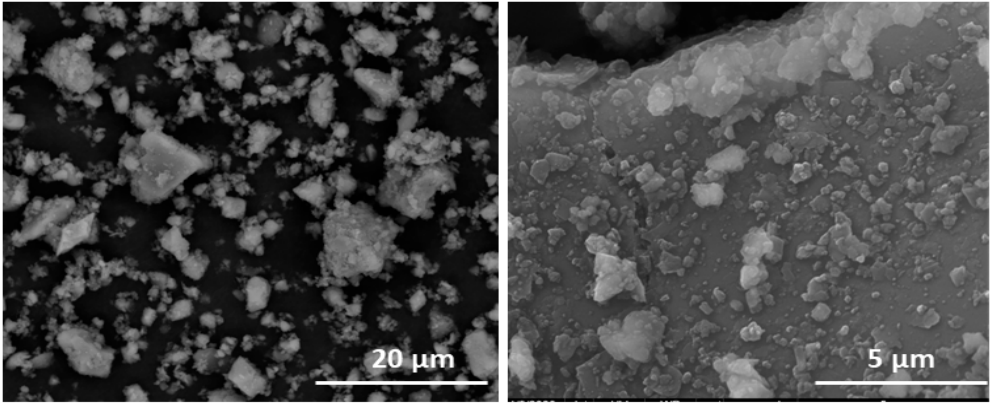
Figure 4. ( left ) Limestone aggregates in HcV. ( right ) Surface deposits on HcV.